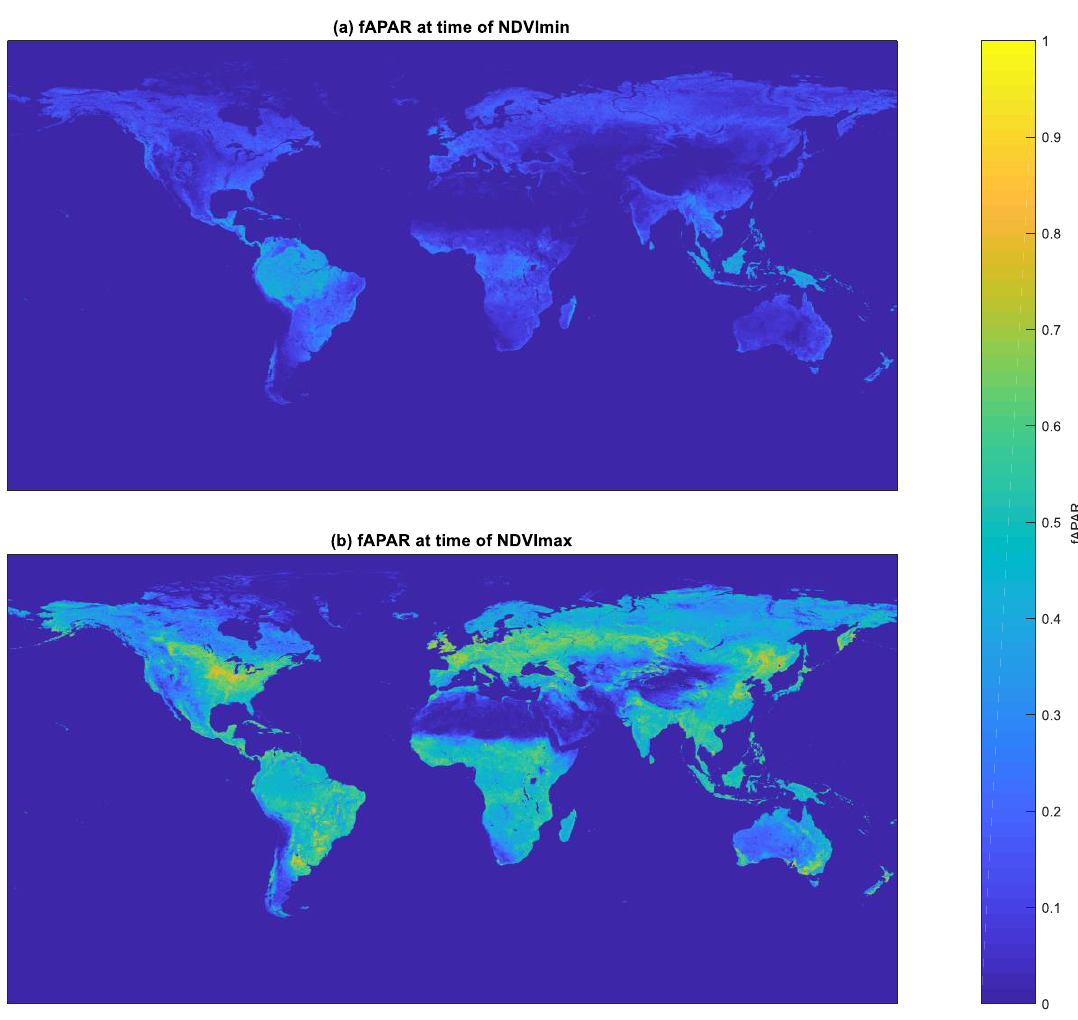
Figure 12. Estimated fAPAR (red band) from the DLUT applied to the red–NIR bands of images of Figure 9.